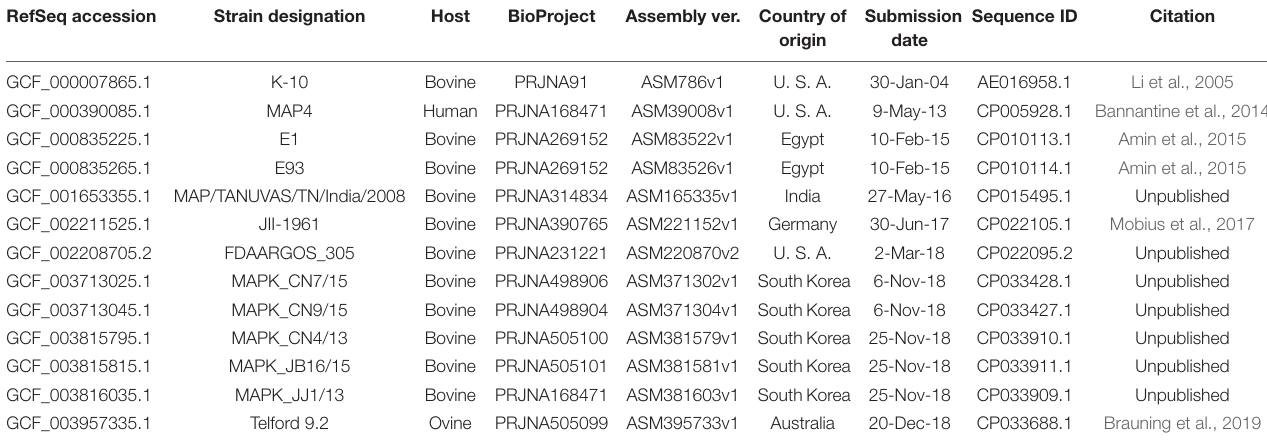
TABLE 1 | Complete RefSeq Map genomes available in